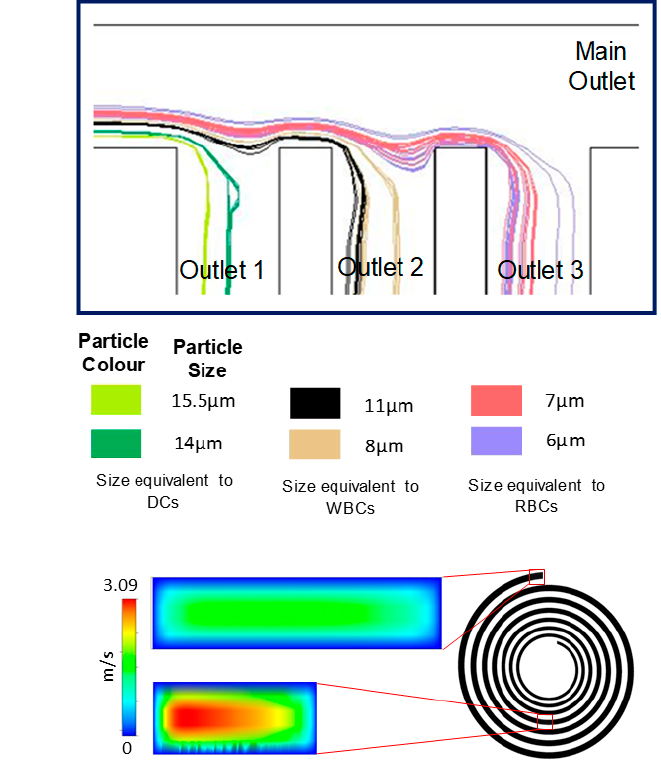
Figure 2. Computational fluid dynamics simulations were used in the design of our device. ( a )